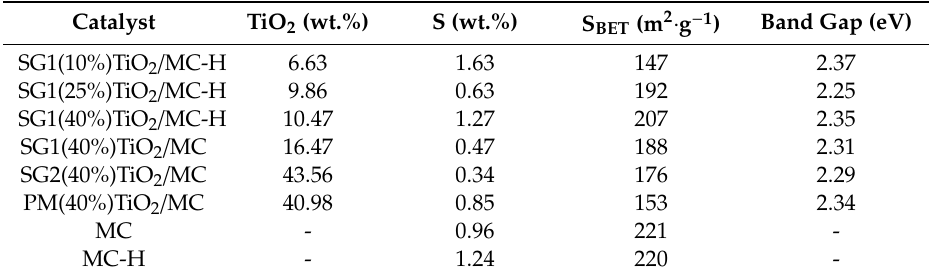
Table 2. Titanium dioxide (TiO 2 ) and sulfur content, Brunauer–Emmett–Teller (BET) surface, and band gap of the di ff erent